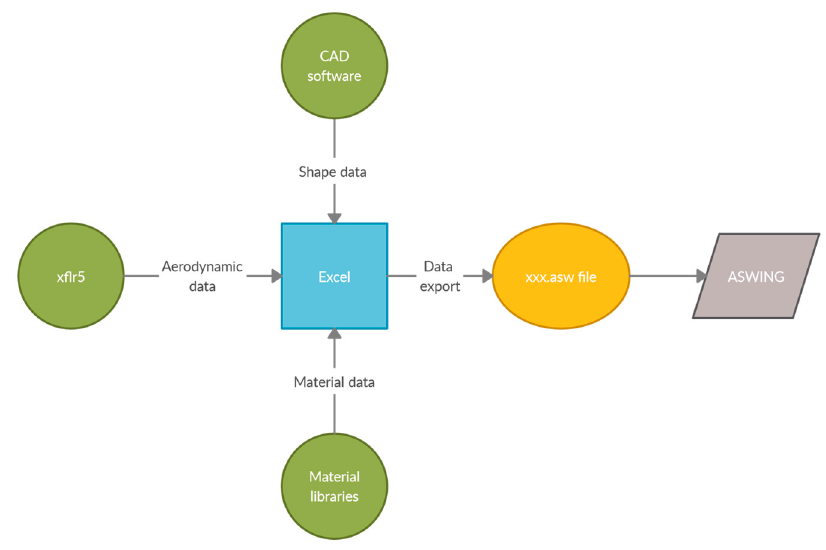
Figure 20. Geometric model used for ASWING analysis.